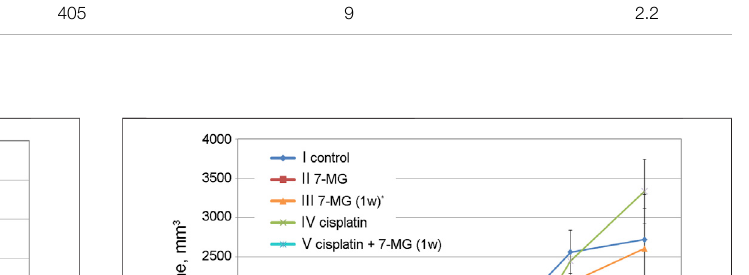
TABLE 4 | Study of the blastomogenic activity of 7-MG in D. melanogaster . Tested compound Dose, mg/vial Number of fl ies Control